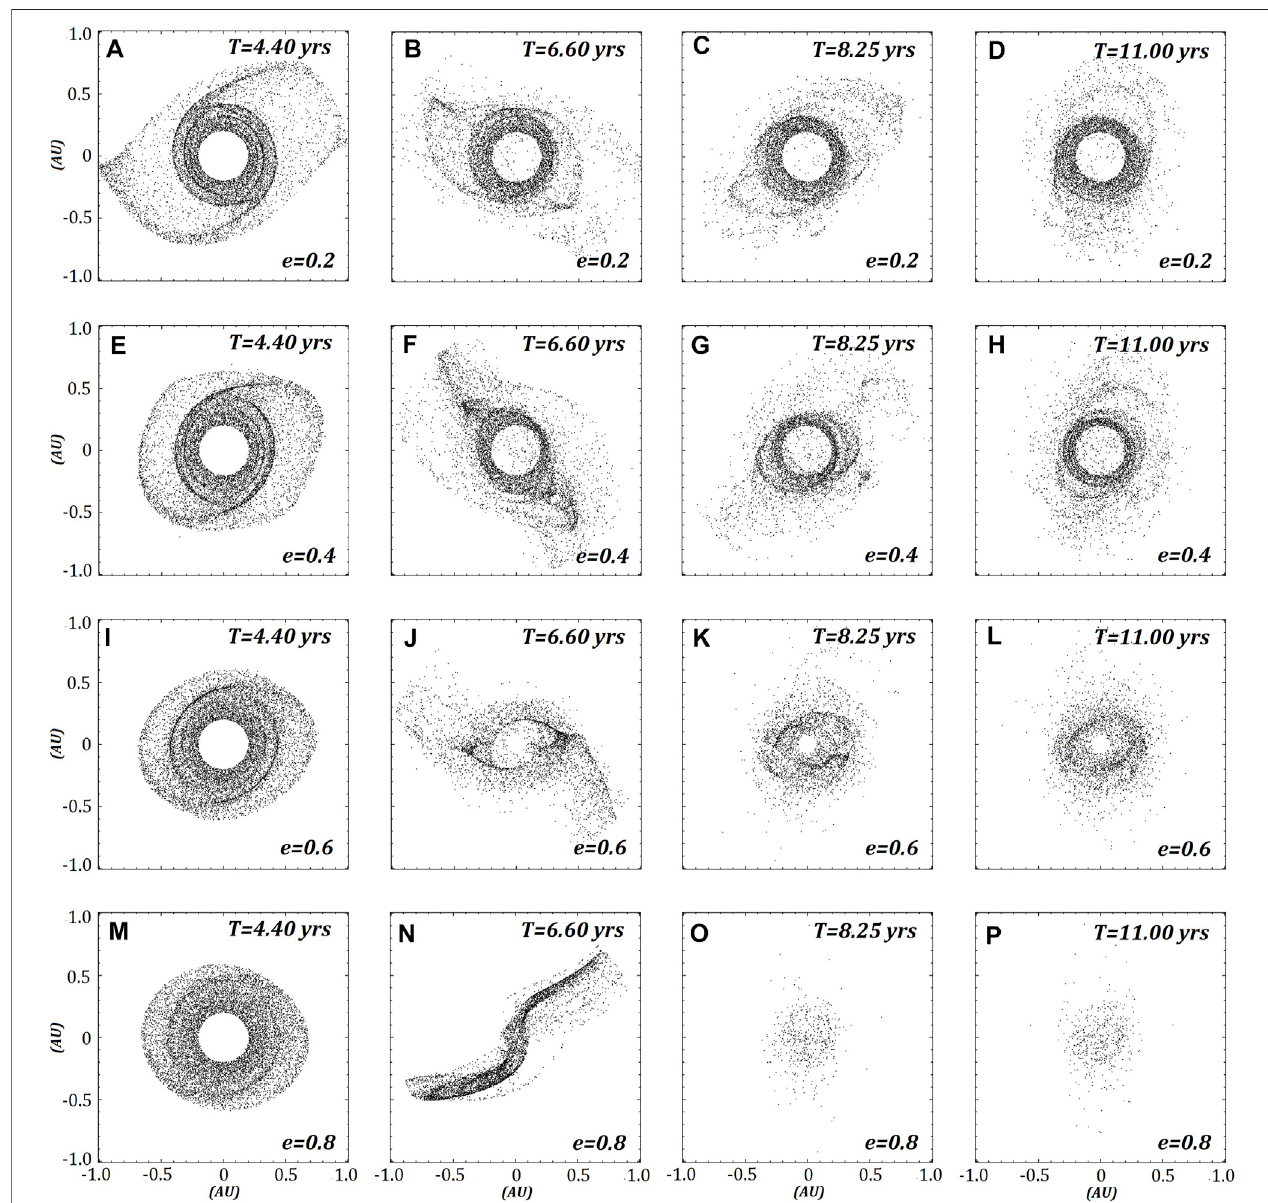
FIGURE 1 | Four models of a ring around J1407b ( M (cid:1) 20 M J ) for one complete orbit ( P (cid:1) 11 yrs ) about the primary. The x and y axes represent the instanteous positions of ring particles around J1407b, which is at the origin. The rows represent each model, where e (cid:1) 0 . 2 (A – D) , e (cid:1) 0 . 4 (E – H) e (cid:1) 0 . 6 (I – L) and e (cid:1) 0 . 8 (M – P) , whilethe columnrepresentsasnapshot intime at T (cid:1) 4 . 40 yrs ( A , E , I & M ) , T (cid:1) 6 . 60 yrs ( B , F , J & N ) , T (cid:1) 8 . 25 yrs ( C , G , K & O ) , T (cid:1) 11 . 00 yrs ( D , H , L & P ) ,where all models began at apocentre.